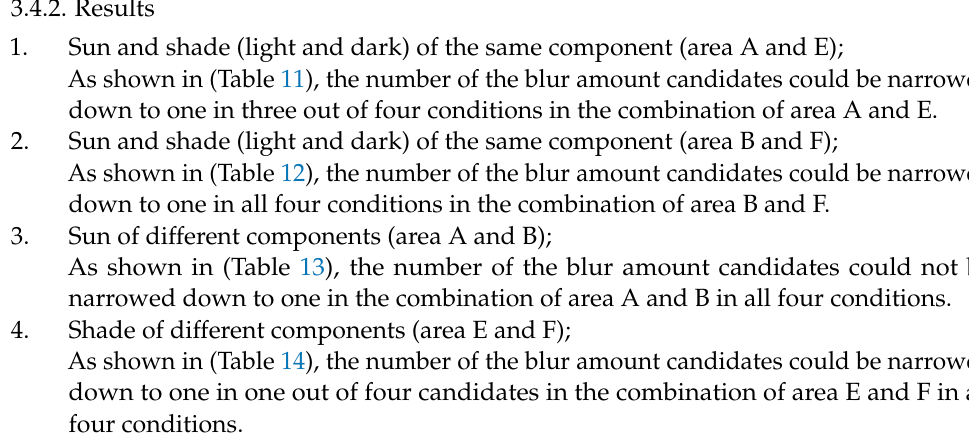
Table 11. Sun and shade; The number of the pixels and their locations where multiple pixels of minimum appeared out of four sub-images out of area A and E. The Blur Amount The Number and Location of Multiple Pixels of Minimum Out of 4 Amount